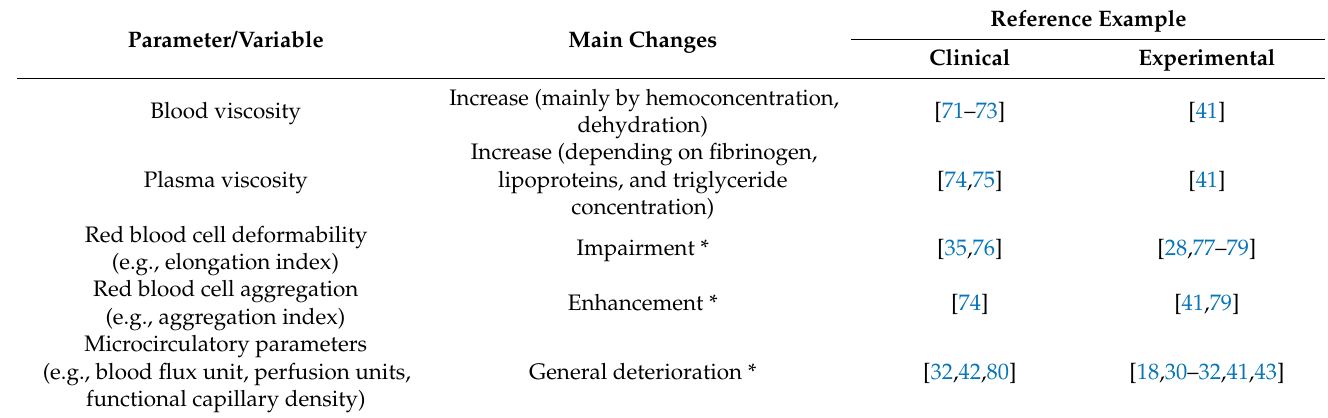
Table 1. Summary of main changes of hemorheological and microcirculatory factors in acute